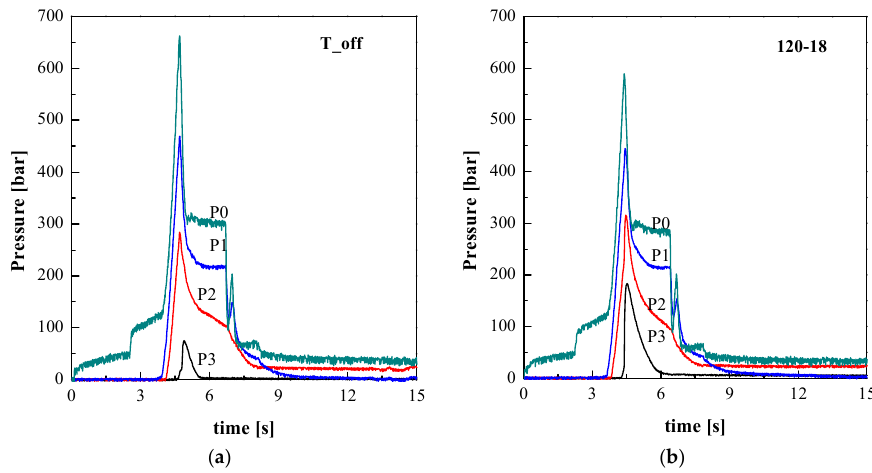
Figure 3. Pressure evolutions measured in different positions along the flow path for the tests ( a ) T_off and ( b ) 120-18.